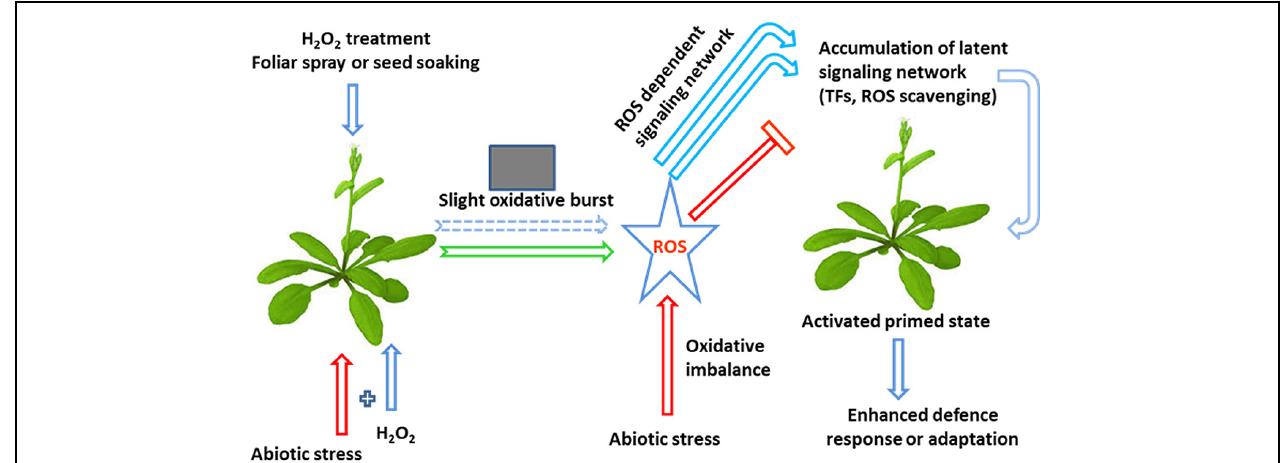
FIGURE 2 | A hypothetical model of the influence of H 2 O 2 on plant defense mechanisms associated with abiotic stresses. H 2 O 2 treatment is capable of inducing abiotic stress tolerance through the development of a small oxidative burst. This burst subsequently activates a ROS-dependent signaling